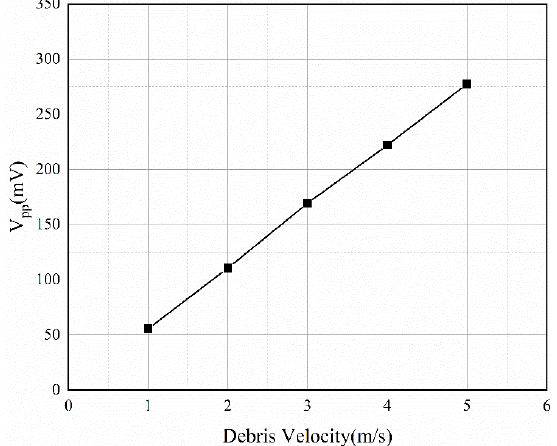
Figure 10. Influence of wear debris